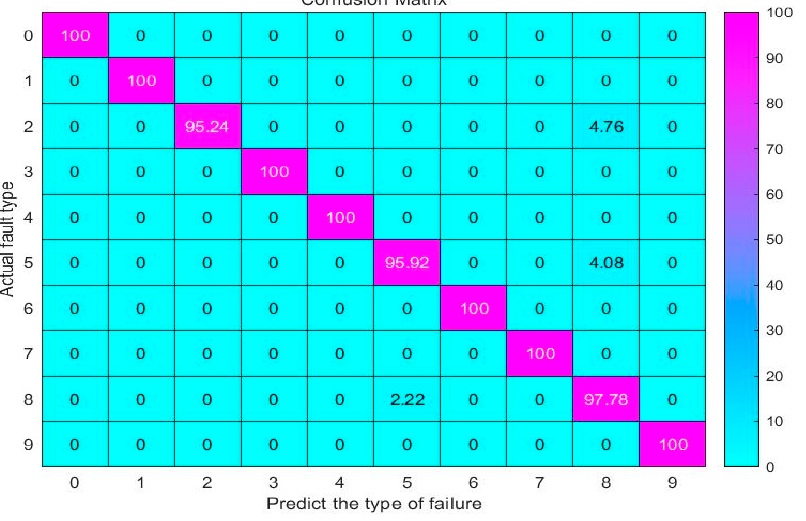
Figure 19. The confusion matrix of 1DCNN.